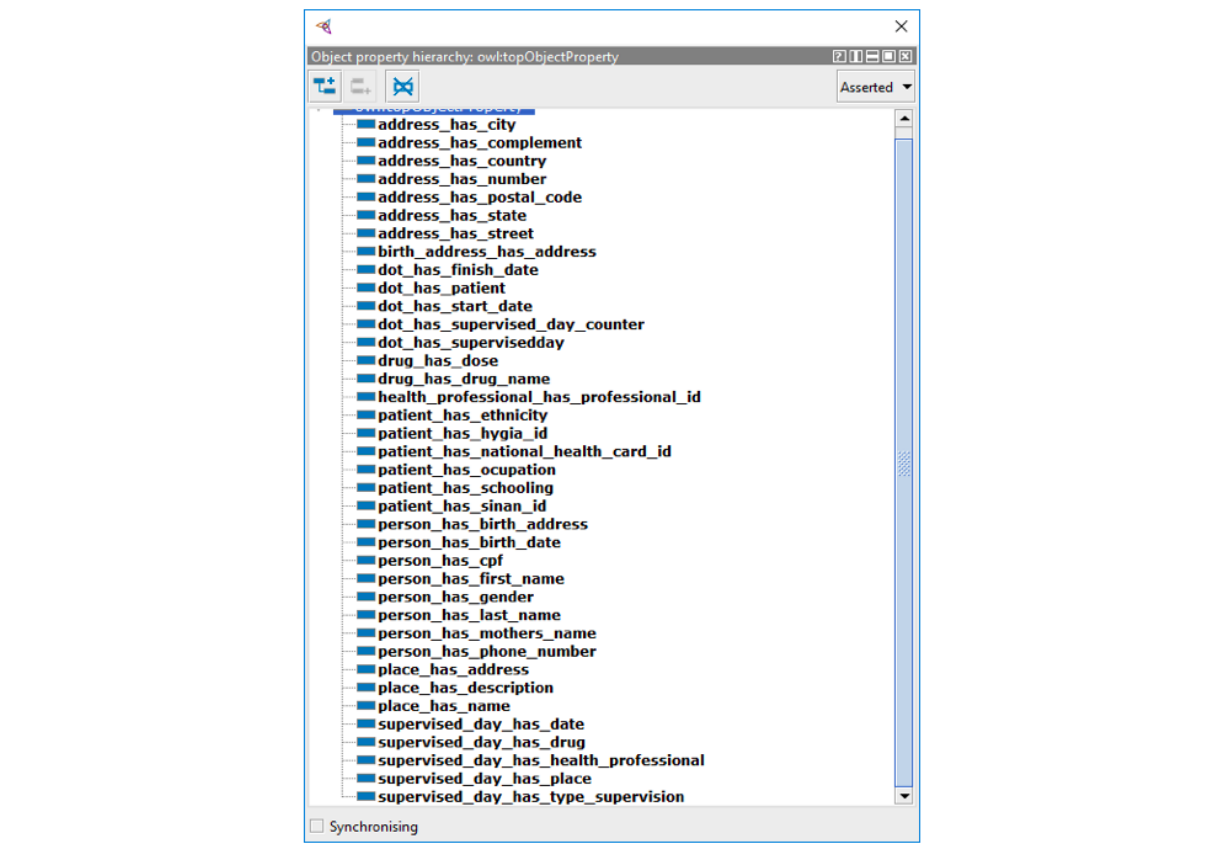
Figure 2. Object properties related to directly observed treatment, short-course